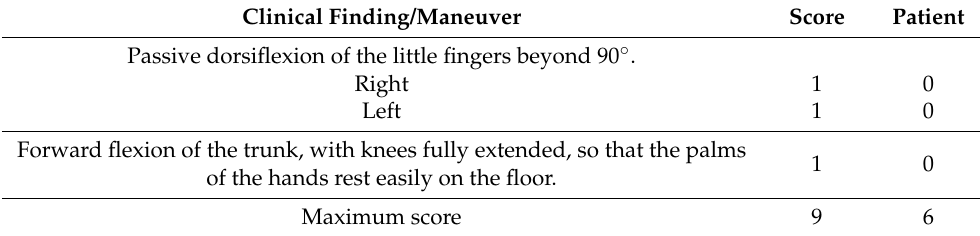
Table 1. Cont . Clinical Finding/Maneuver Score Patient Passive dorsiflexion of the little fingers beyond 90 ◦ . Right 1 0 Left 1 0 Forward flexion of the trunk, with knees fully extended, so that the palms of the hands rest easily on the